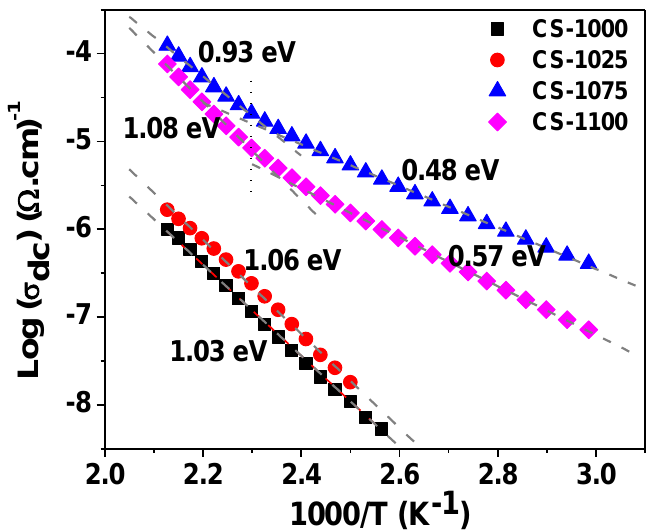
Figure 9. The Arrhenius plots of dc conductivity for CS-1000, CS-1025, CS-1075, and CS-1100 NSCTO samples.